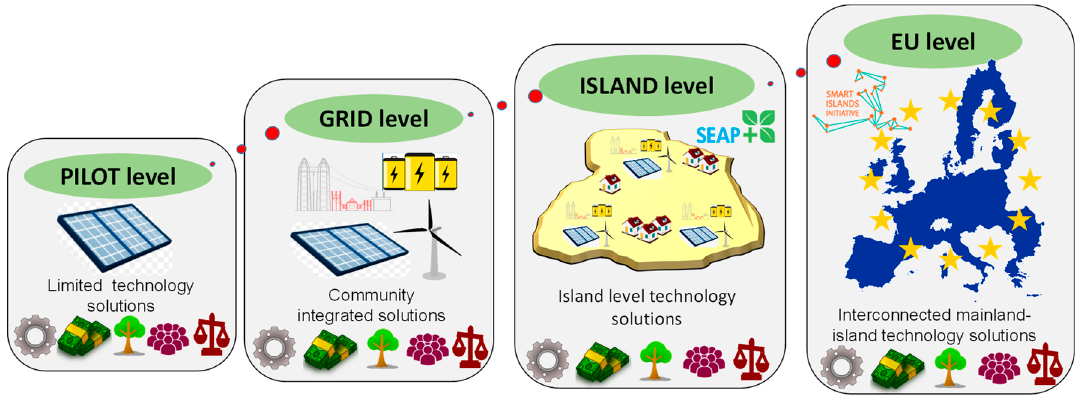
Figure 4. Schematic Depiction of the Local-to-Global strategy.